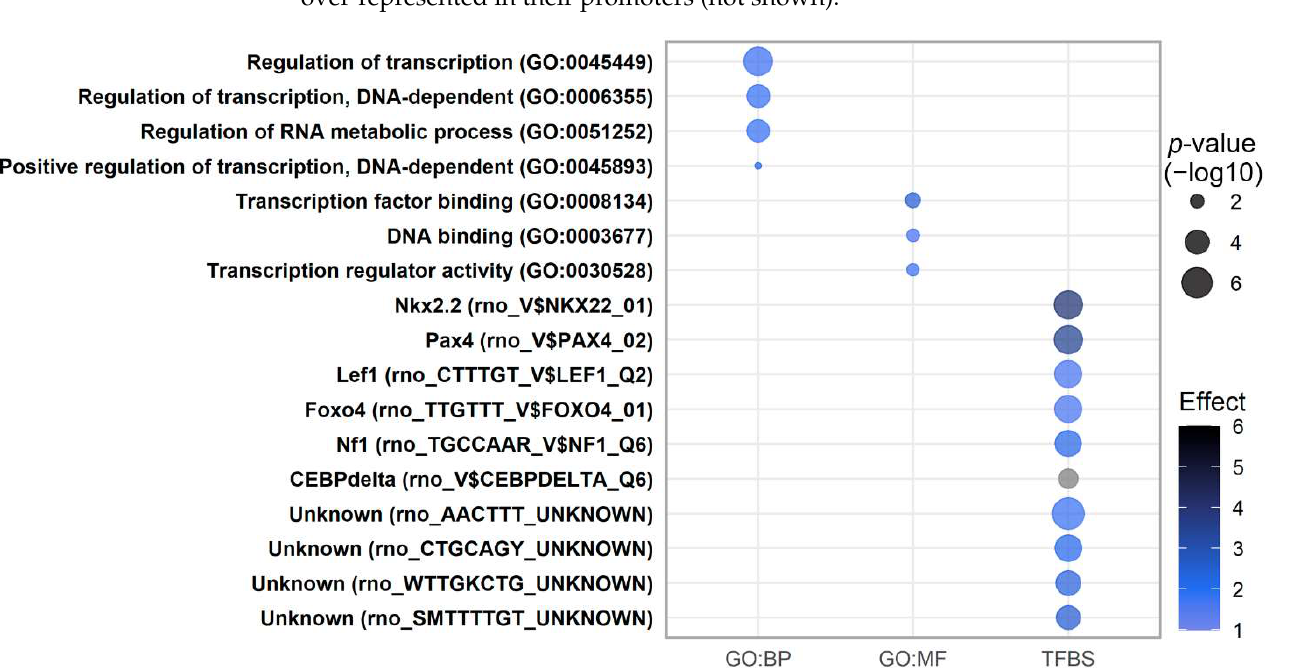
Figure 7. Gene Ontology biological processes (GO:BP) and molecular functions (GO:MF), which are significantly over-represented in the gene lists of downregulated genes caused by the low-protein diet, and significantly enriched transcription factor binding sites (TFBS) based on downregulated genes caused by the low-protein diet during gestation.